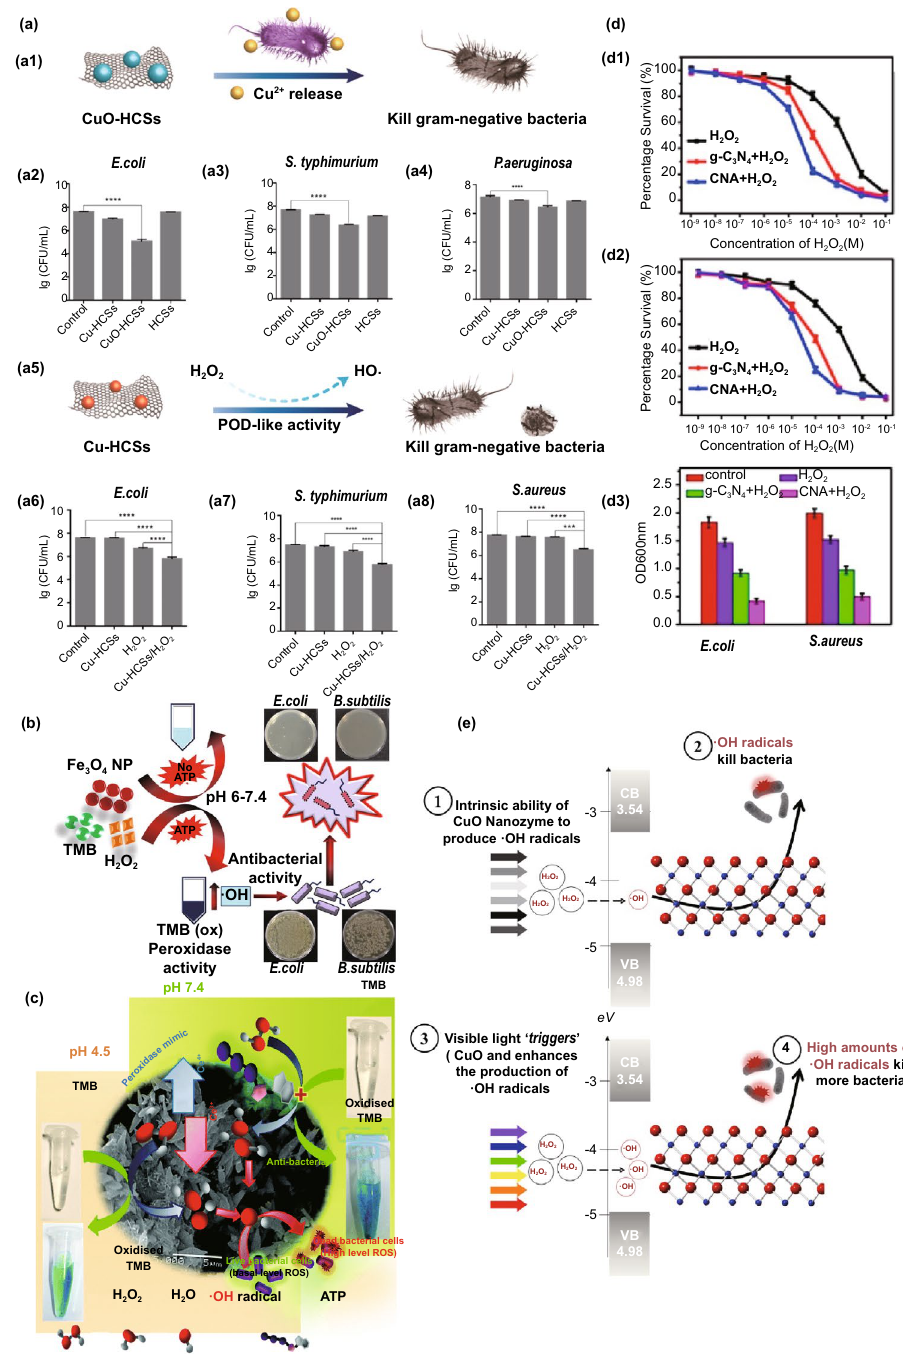
Fig. 9 a1 , a5 Antibacterial mechanism of Cu/C nanozymes with two Cu states (Cu 0 and Cu 2+ ). The actual antibacterial ability of CuO-HCSs, Cu-HCSs and HCSs against a2 E. coli , a3 S. typhimurium , and a4 P. aeruginosa . The actual antibacterial ability of Cu-HCSs, H 2 O 2 and Cu- HCSs/H 2 O 2 against a6 E. coli , a7 S. typhimurium and a8 S. aureus. b Antibacterial activity against E. coli and B. subtilis of Fe 3 O 4 NPs before and after ATP introduction at pH 6–7.4. c Catalytic activity of CeO 2 nanocrystals before and after ATP introduction at pH 4.5 and 7.4. The bac- terial viability of d1 E. coli and d2 S. aureusand with different treatments (H 2 O 2 , g-C 3 N 4 + H 2 O 2 , CNA + H 2 O 2 ). d3 Optical density at 600 nm of bacterial suspension in different solutions. e Schematic illustration of the antibacterial principle of CuO NRs with the light as external triggers. Adapted from a Ref. [232], b Ref. [378], c Ref. [379], d Ref. [382], e Ref. [369] with